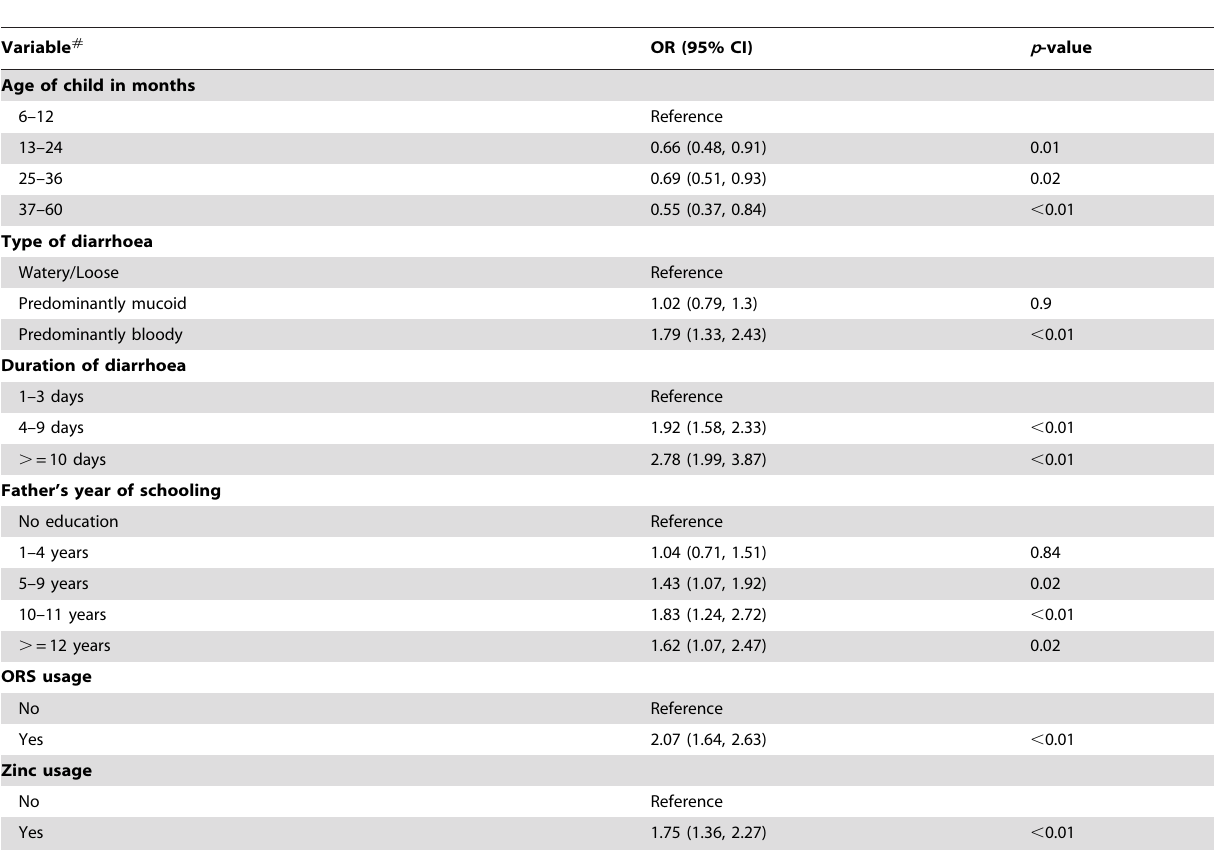
Table 5. Predictors of antibiotic usage in childhood diarrhoea after controlling area and time variation.